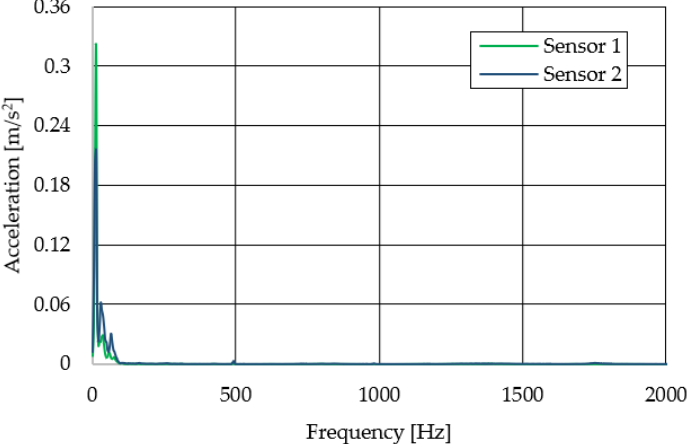
Figure 22. Comparison of the frequency waveforms in the z -axis during asymmetrical crossing over the obstacle by the left wheel.